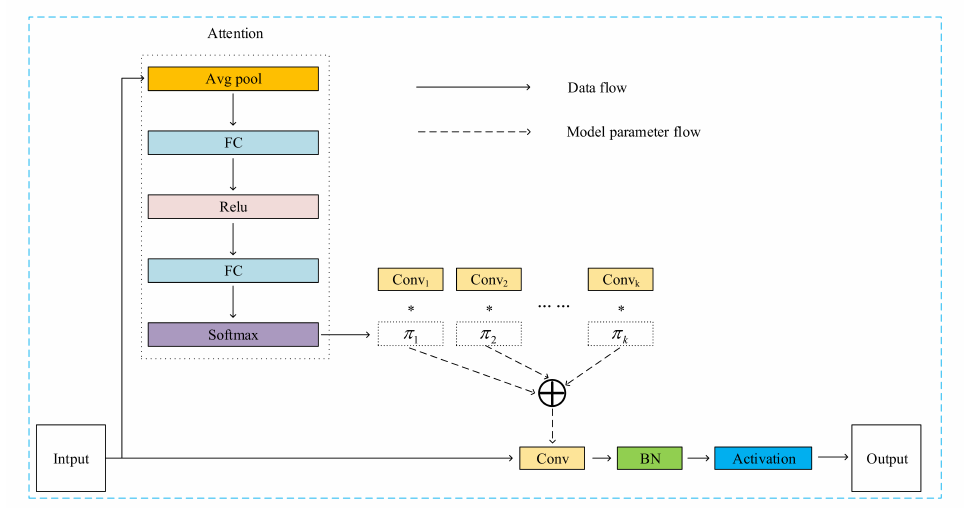
Figure 4. Dynamic convolution structure.